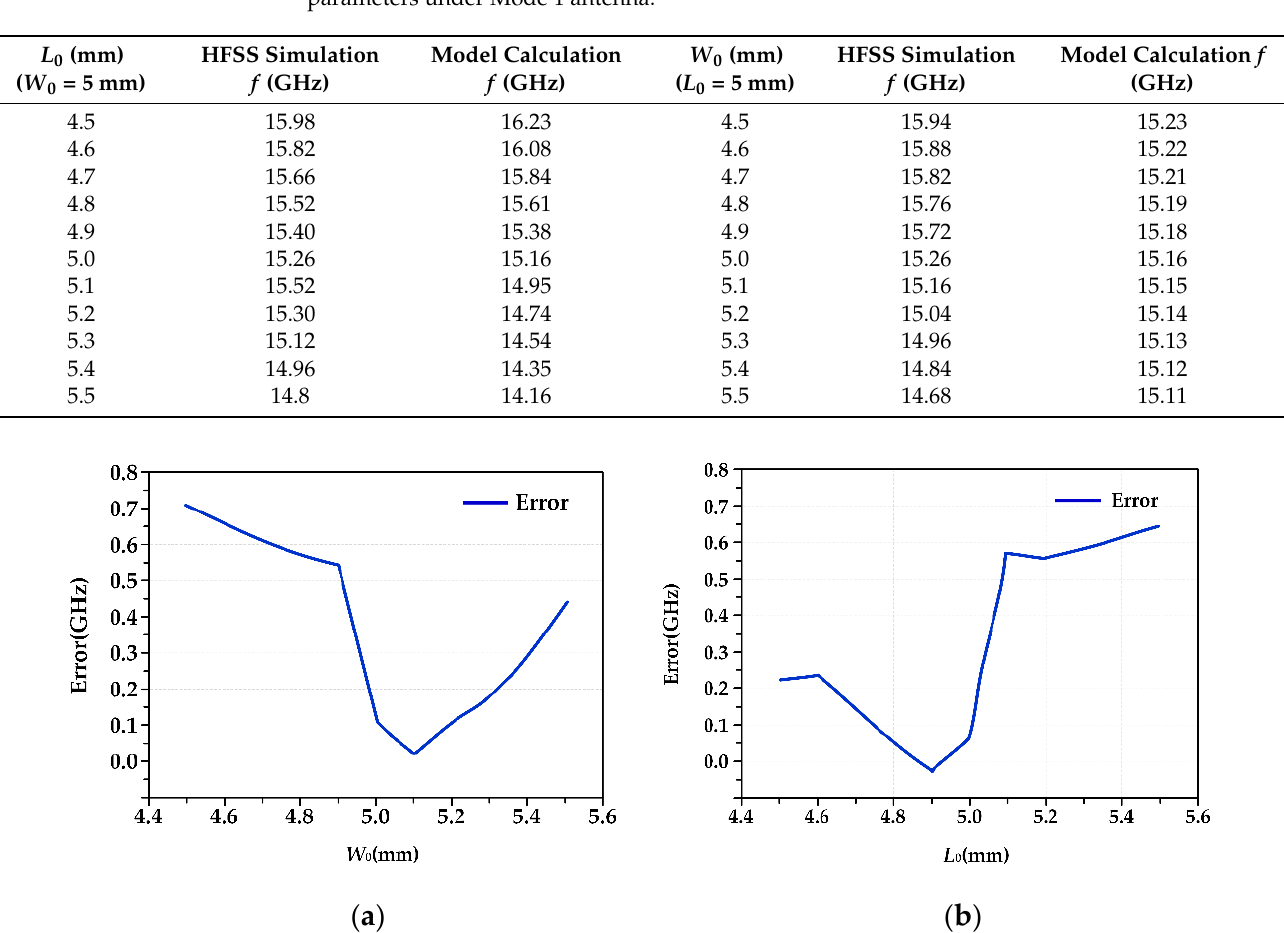
Table 6. HFSS simulation results and coupling model calculation results of different W 0 and L 0 parameters under Mode 1 antenna.